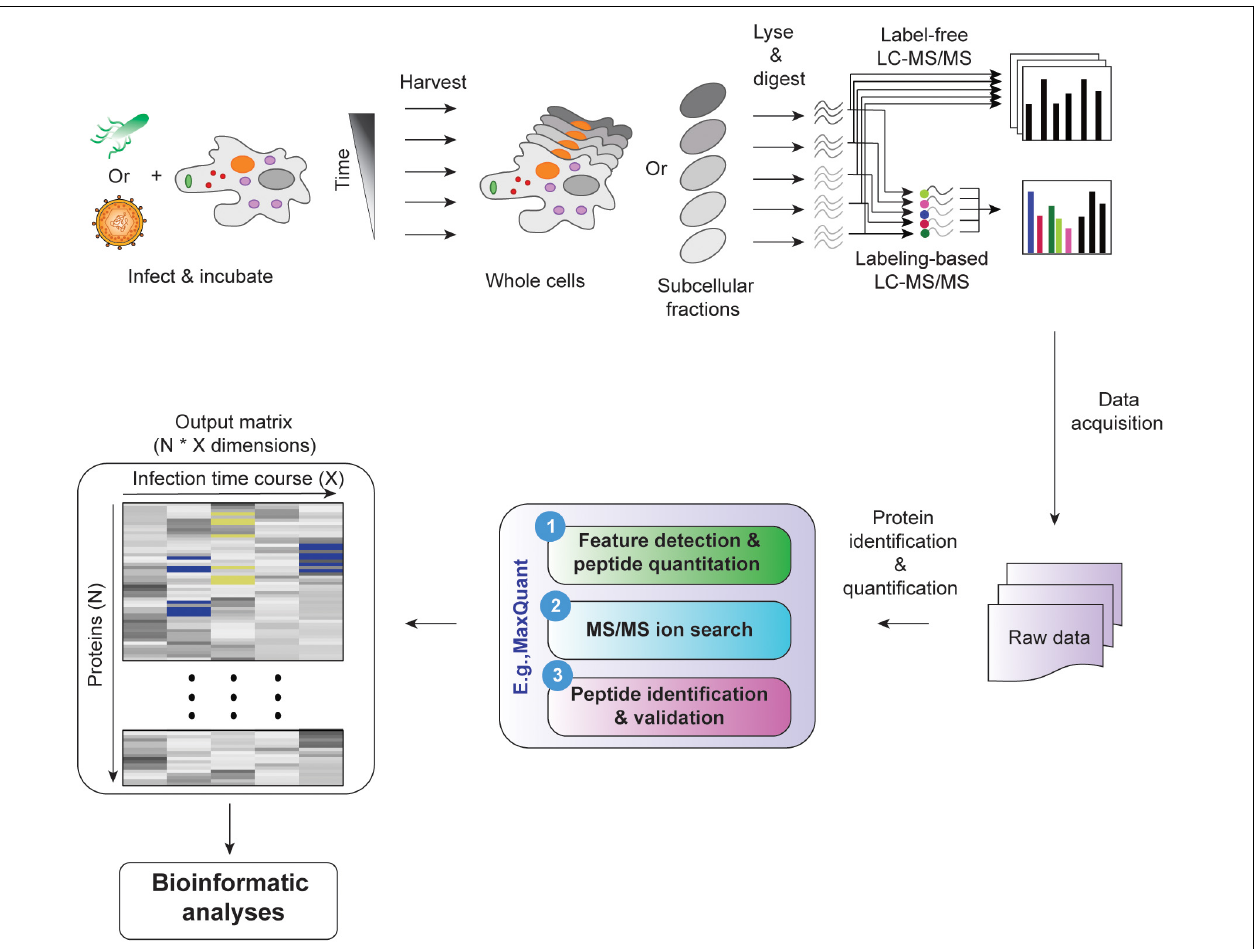
FIGURE 1 | Temporal MS-based proteomic HPI studies combine advanced experimental platforms, instrumentation, and software to study alterations in protein abundances over the course of an infection. Following infection, cells (whole-cell temporal proteomics) or organelles (organelle temporal proteomics) are harvested at different time points post-infection, followed by lysis and proteolysis. The resulting peptides are then analyzed by label-free or multiplexed label-based (e.g., TMT or SILAC) quantitative MS (for a review, see Jean Beltran et al., 2017). Software, such as MaxQuant can be used to process the data and generate a multidimensional matrix that contains information about protein identities (N) and their relative abundances across X time points in infected vs. uninfected samples. This is then used to assess temporal changes in cell proteome during